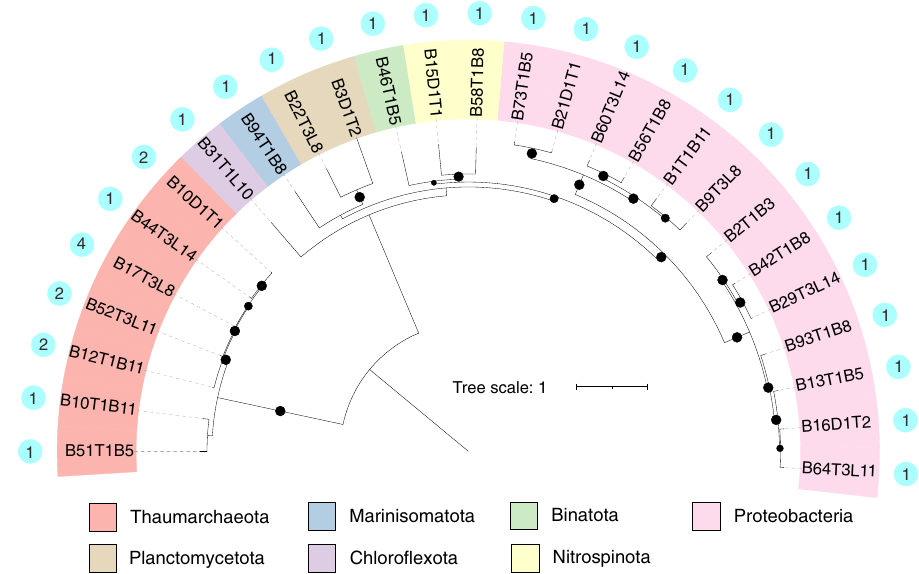
Fig. 5 Challenger Deep virus-host linkages. Maximum-likelihood phylogenetic tree of prokaryotic genomes (phylum level). The outermost dots denote the number of viruses that infected the cofactors and vitamins (Supplementary Fig. 5 and Supplementary